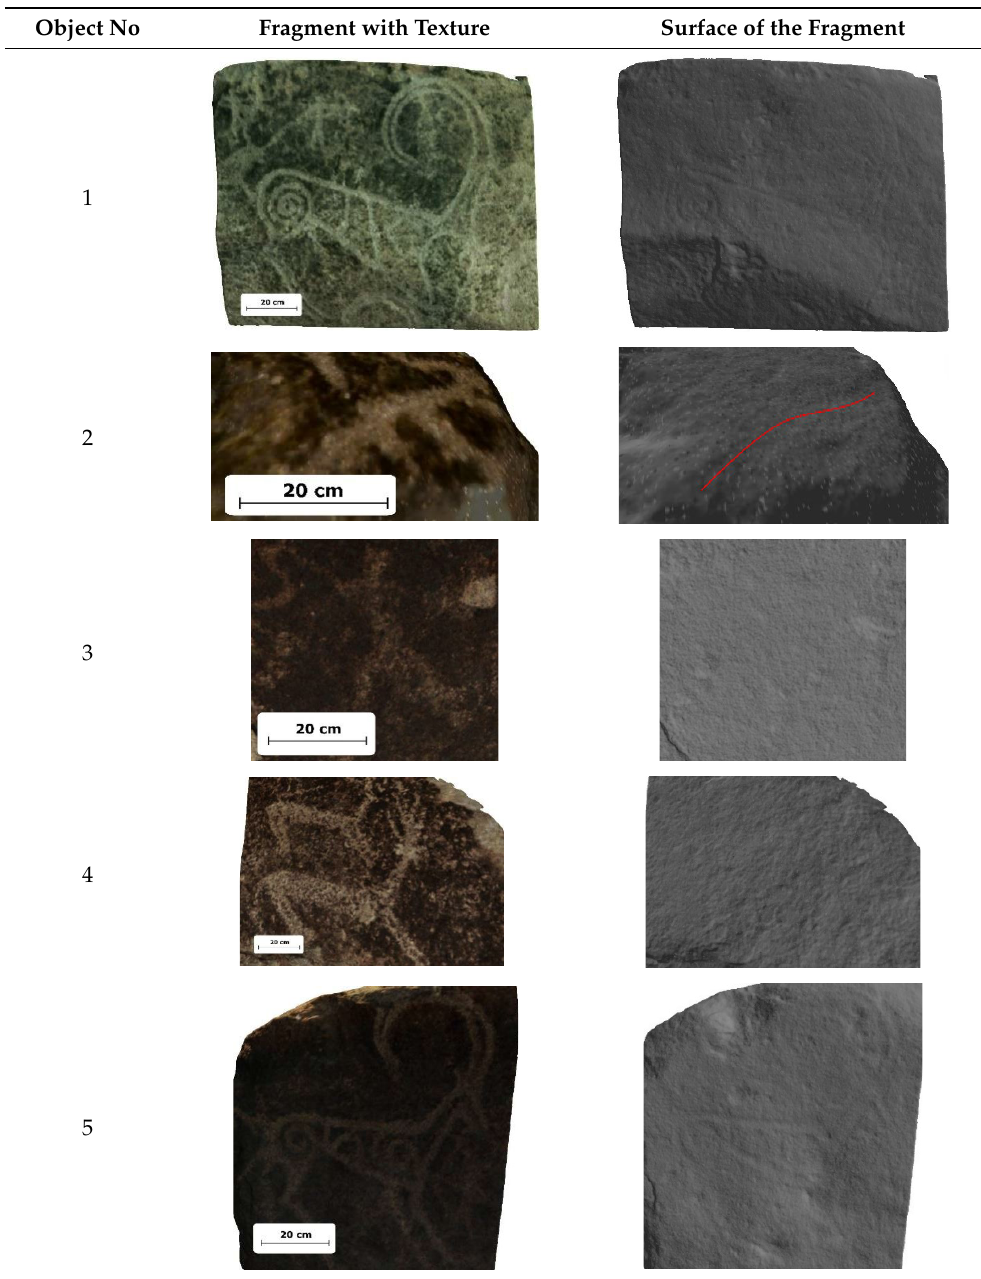
Table 4. The visibility of carvings in petroglyph drawings.